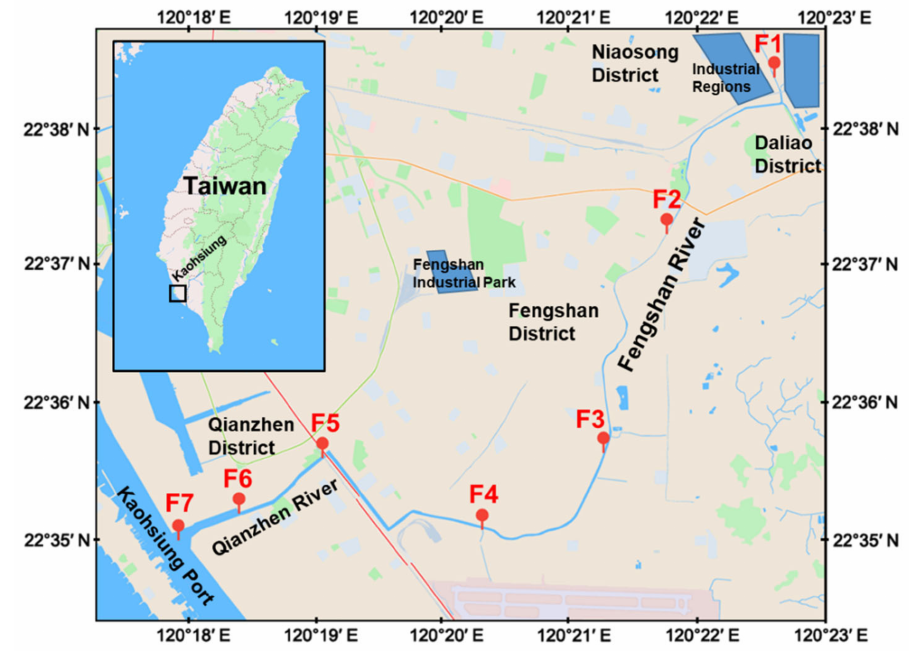
Figure 1. Sampling sites along Fengshan River in Kaohsiung City,